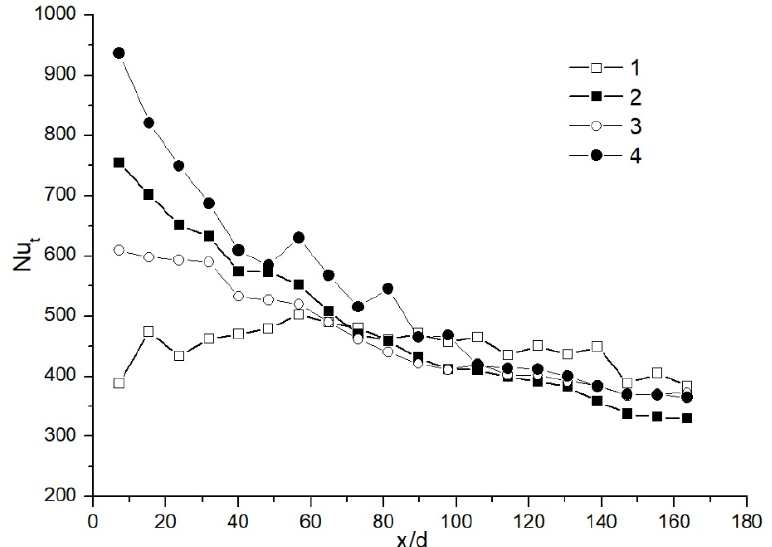
Figure 10. Distribution of the total local Nusselt number along the model of the condensing heat exchanger at Re in ≈ 9500 for the different inlet flue gas and injected water temperatures: (1) t in ≈ 87 °C and injected water temperature 25 °C, (2) t in ≈ 88 °C and injected water temperature 40 °C, (3) t in ≈ 122 °C and injected water temperature 25 °C, (4) t in ≈ 125 °C and injected water temperature 40 °C.